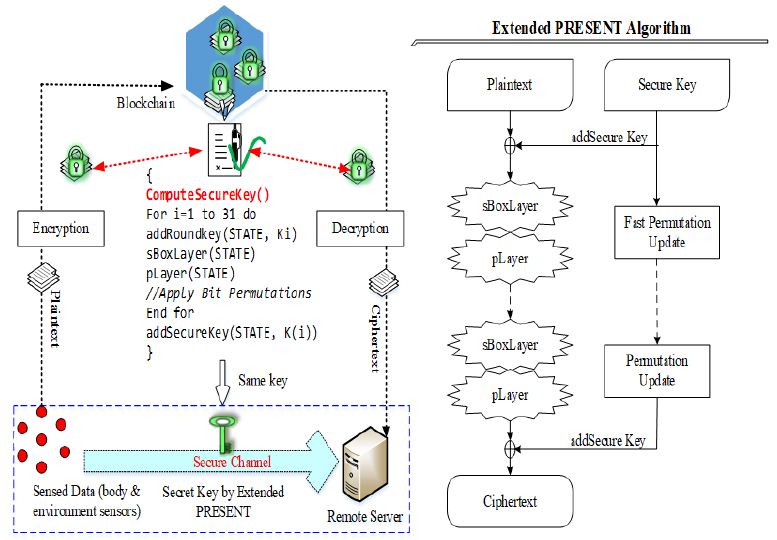
Figure 4. Extended version of PRESENT